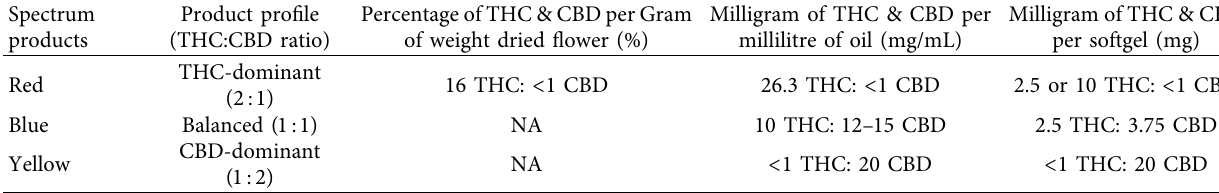
Table 1: Spectrum therapeutics product avalibility in